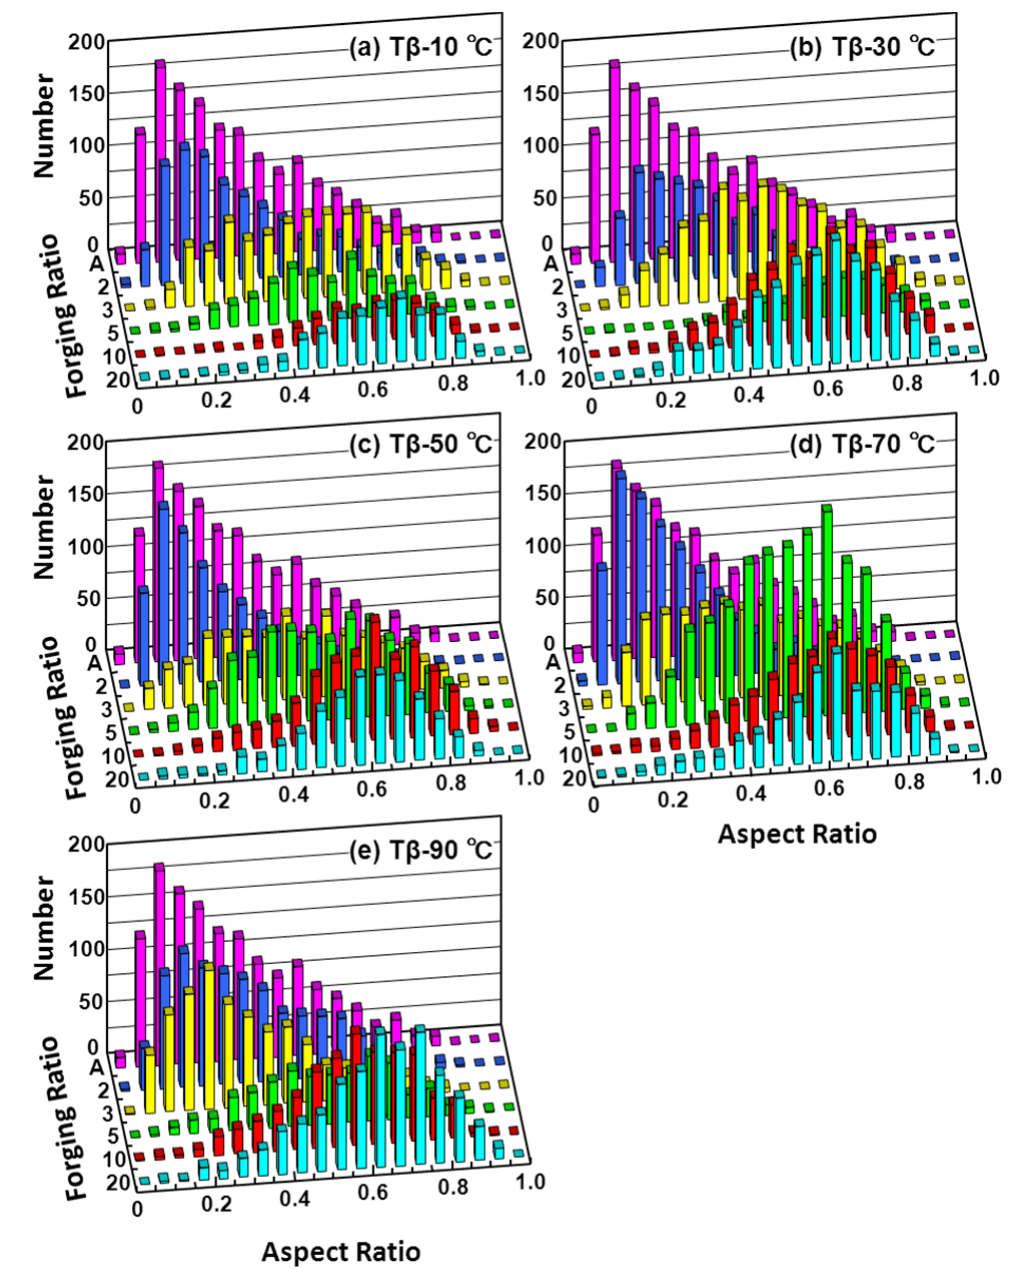
Figure 10. Change in aspect ratio of α -phase as a function of forging ratio and difference ( Δ T) between T β and heat treatment